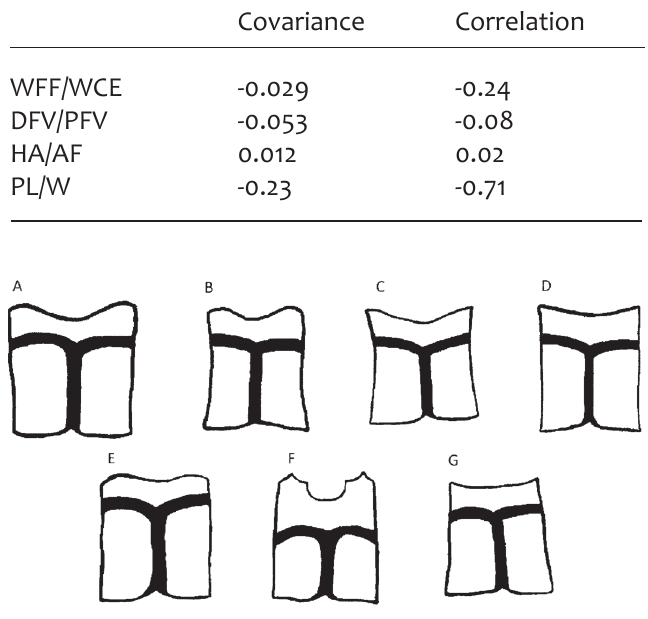
Figure 10. Pygal bones of Chrysemys picta bellii. A, Neb 3; B, Neb 4; C, Neb 5; D, Neb 12; E, Neb 13; F, Neb 14; and G, ODFW